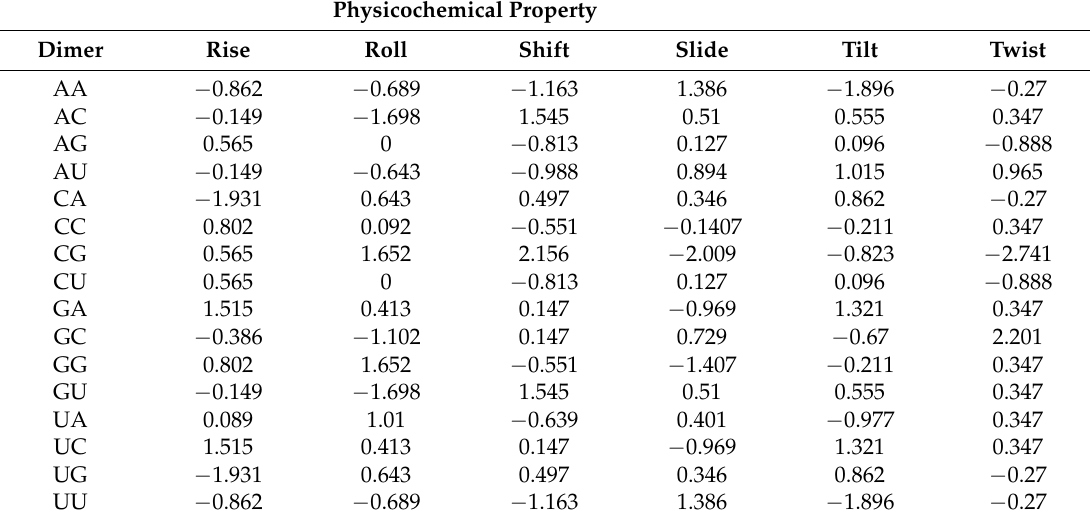
Table 1. The Normalized Values of Rise, Roll, Shift, Slide, Tilt, and Twist for the 16 Dinucleotides in